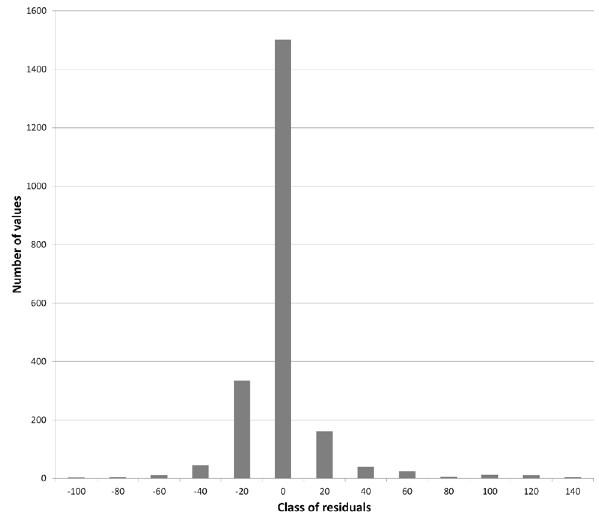
Fig. 6. Number of values in each class of residuals (classes named according to their lower boundary).